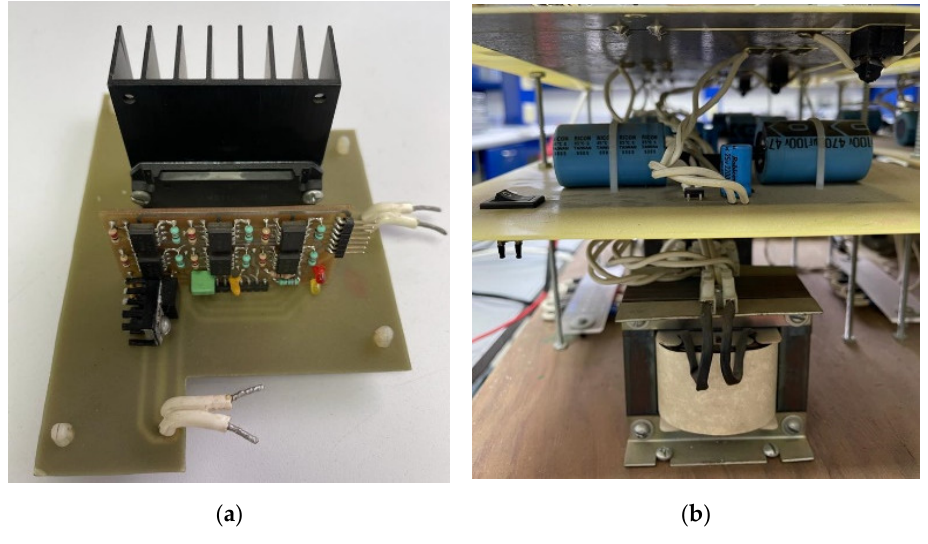
Figure 14. Power platform: ( a ) stage 1 and ( b ) stage 2.